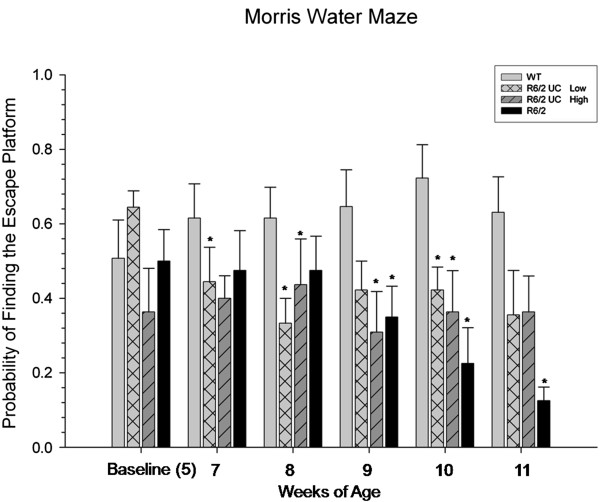
Spatial memory assessment of R6/2 mice following umbilical cord mesenchymal stem cell (UC MSC) transplantation. Untreated R6/2 mice displayed significant impairment in spatial memory at 9-, 10- and 11-weeks of age when compared to WT mice. Mice receiving either low- or high-passaged UC MSCs did not display sparing of this spatial memory task. (Note: *significant from WT) Bar graph represents mean value; error bars represents SEM. SEM, stanrard error of the mean; WT, wild type.